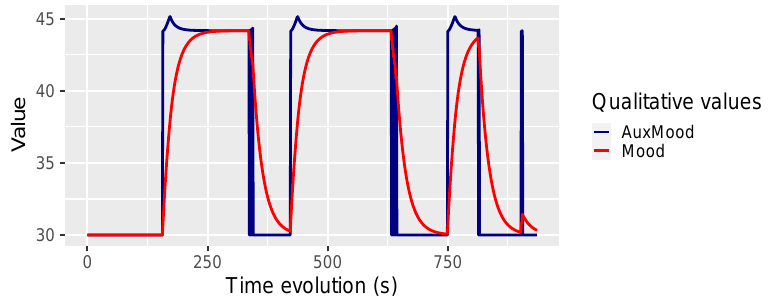
Figure 11. Comparison between the non-filter MOOD and the filter